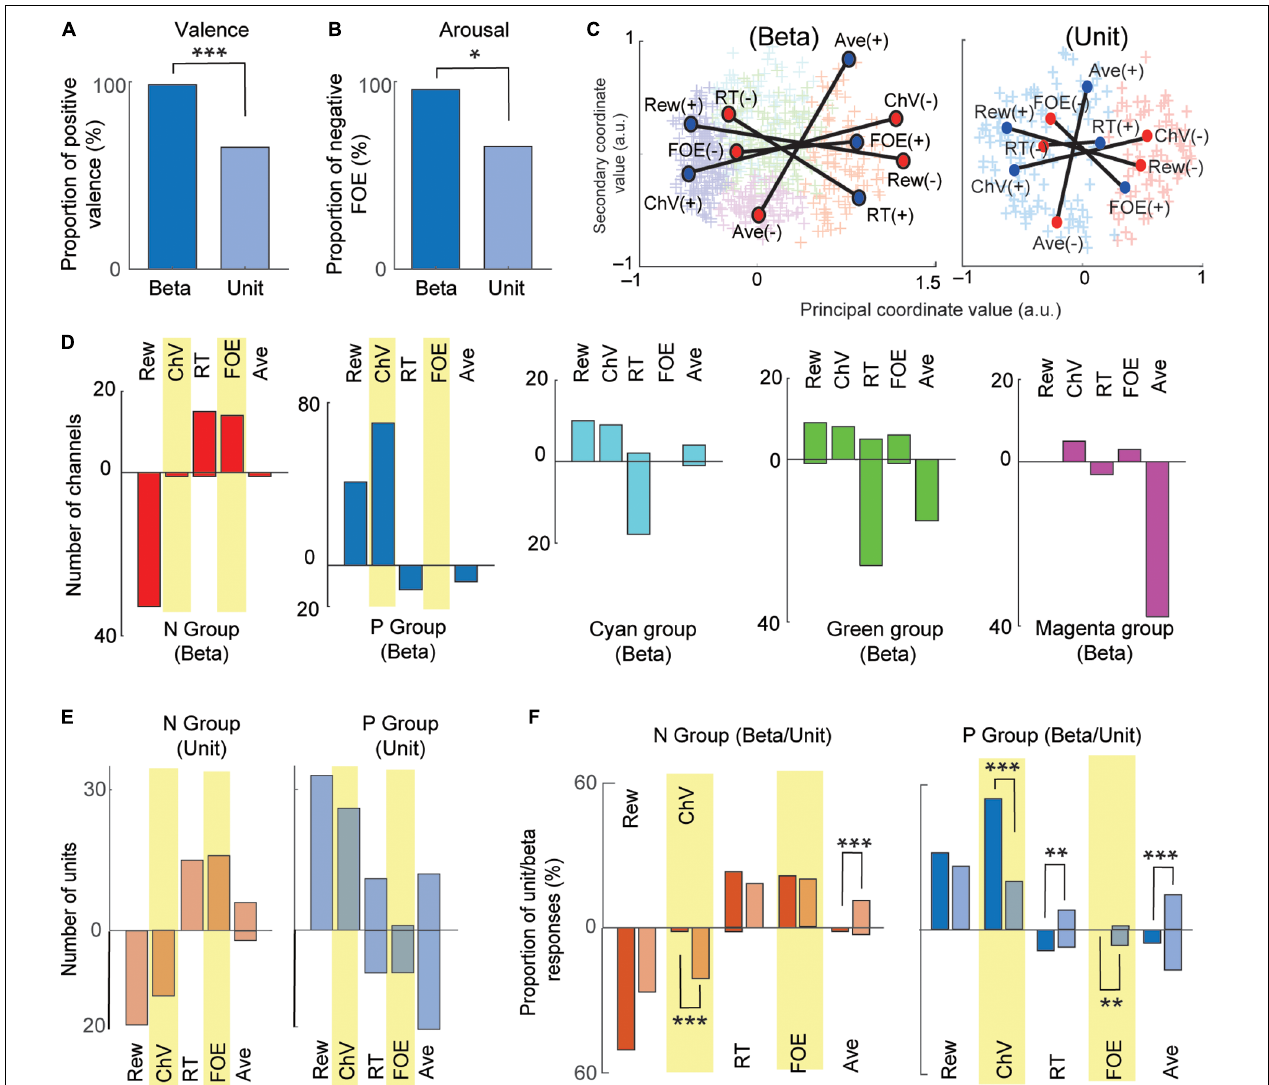
FIGURE 5 | Comparison between beta and unit that encoded valence and arousal. (A) Comparison between valence-encoding beta and valence-encoding unit responses. The percentage of positive-valence beta responses was significantly larger than that of unit responses (Fisher’s exact test, *** P < 0.001). (B) Comparison between the arousal-encoding beta and unit responses. The percentage of the negative-arousal beta responses was significantly larger than that of unit responses (Fisher’s exact test, * P < 0.05). (C) MDS clustering for the beta (left) and unit (right) responses. The beta and unit responses were projected onto the first two dimensions of the MDS (MDS map). Each cross indicates an individual response. Two groups (P and N groups) were defined by the Gaussian mixture model. The positions of the five explanatory variables were projected onto the MDS map. Blue and red circles indicate, respectively, positive and negative correlation with the variables. (D) The representation of beta responses for each group identified by the MDS clustering. The number of beta responses encoding the five behavioral variables shown separately for each group. The stacked bars that go up indicated positive correlations, and those that go down indicated negative correlations. (E) The representation of unit responses for N and P groups identified by the MDS clustering. Stacked bars that go up and down indicate positive and negative correlations, respectively. (F) Comparison of beta and unit responses in the P and N groups (dark colors, beta; light colors, units). Stacked bars that go up and down indicate positive and negative correlations, respectively. Statistically significant differences between the proportion of units and proportion of beta are marked (Fisher’s exact test, *** P < 0.001, ** P < 0.01).